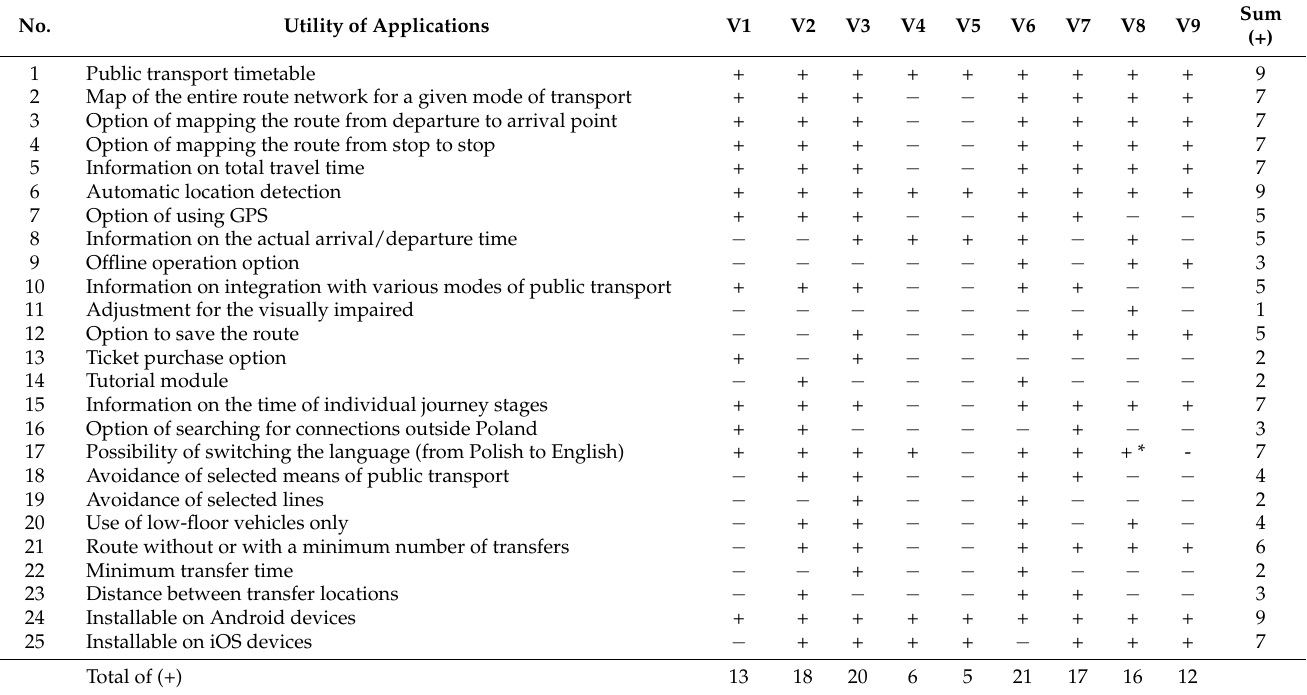
Table 2. Overview of available functions per